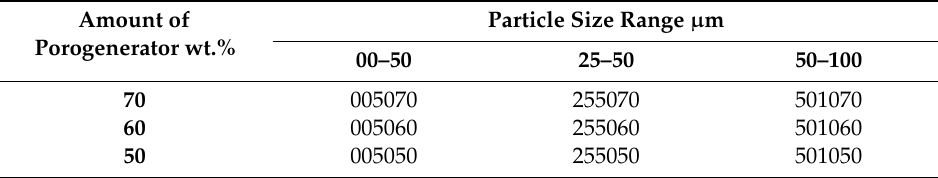
Table 1. Identifier numbers of the considered porogenerator amounts and particle size ranges. Mixtures containing 50%, 60%, and 70% in weight of salt particles in 0–50- µ m, 25–50- µ m and 50–100- µ m size ranges were